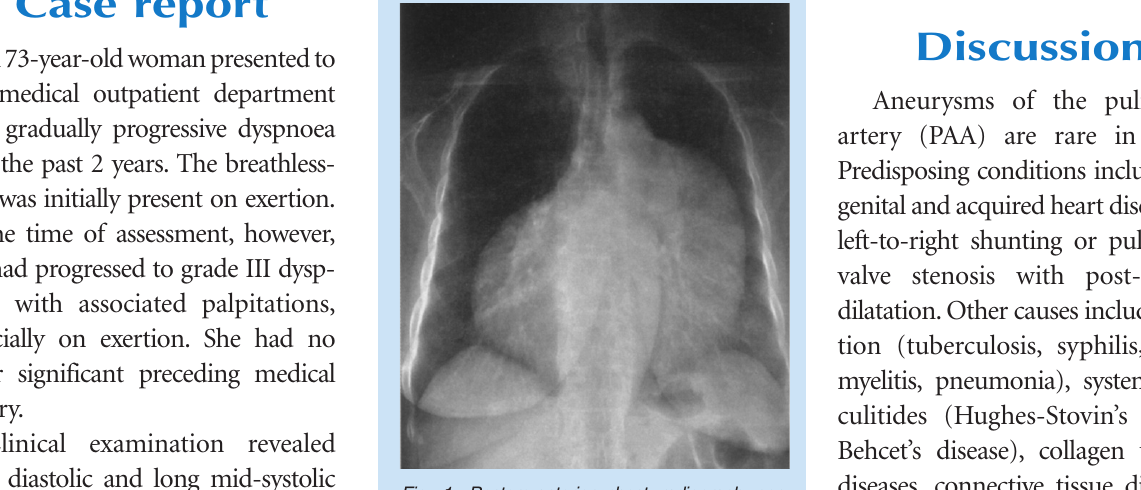
Fig. 1. Postero-anterior chest radiograph per- formed on admission.